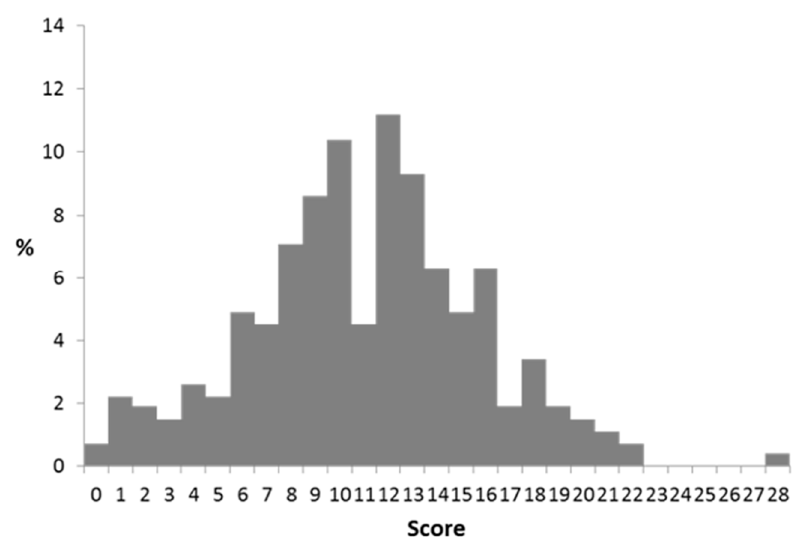
Figure 2. CoMiSS distribution at baseline. Legend : Y ‐ ass: percent of infants, X ‐ ass: CoMiSS score. Overall, the mean and median CoMiSS was 11.1 and 11.0, respectively, and 72.3% of subjects had a CoMiSS of >9 and 48.9% a CoMiSS > 12. The CoMiSS score was lowest in the UK. Stratification of CoMiSS according to the cut ‐ off value of 12 divided the infants in two roughly equal groups. However, country ‐ specific CoMiSS stratification reflected that the majority of British and German subjects had scores below <12 (78% and 81%, respec ‐ tively), while the majority of the Czech infants (82%) had CoMiSS of >12 (Table 7).